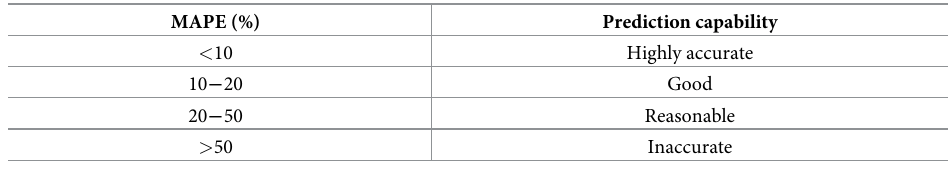
Table 2. Forecast ability levels of